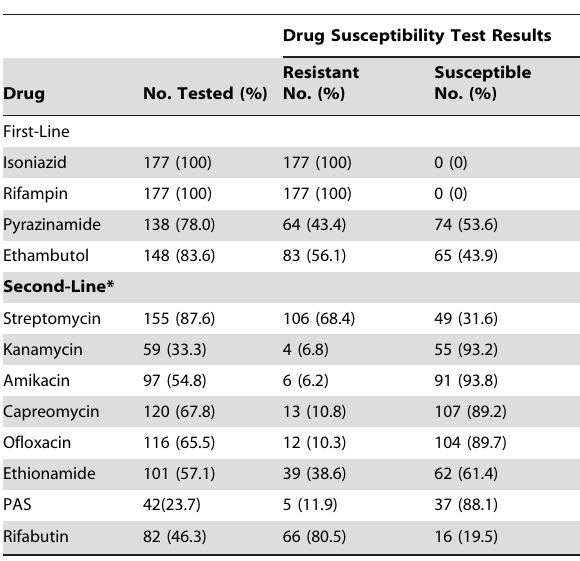
Table 3. First- and second-line anti-tuberculosis drug- susceptibility test results of MDR tuberculosis case isolates in Canada,